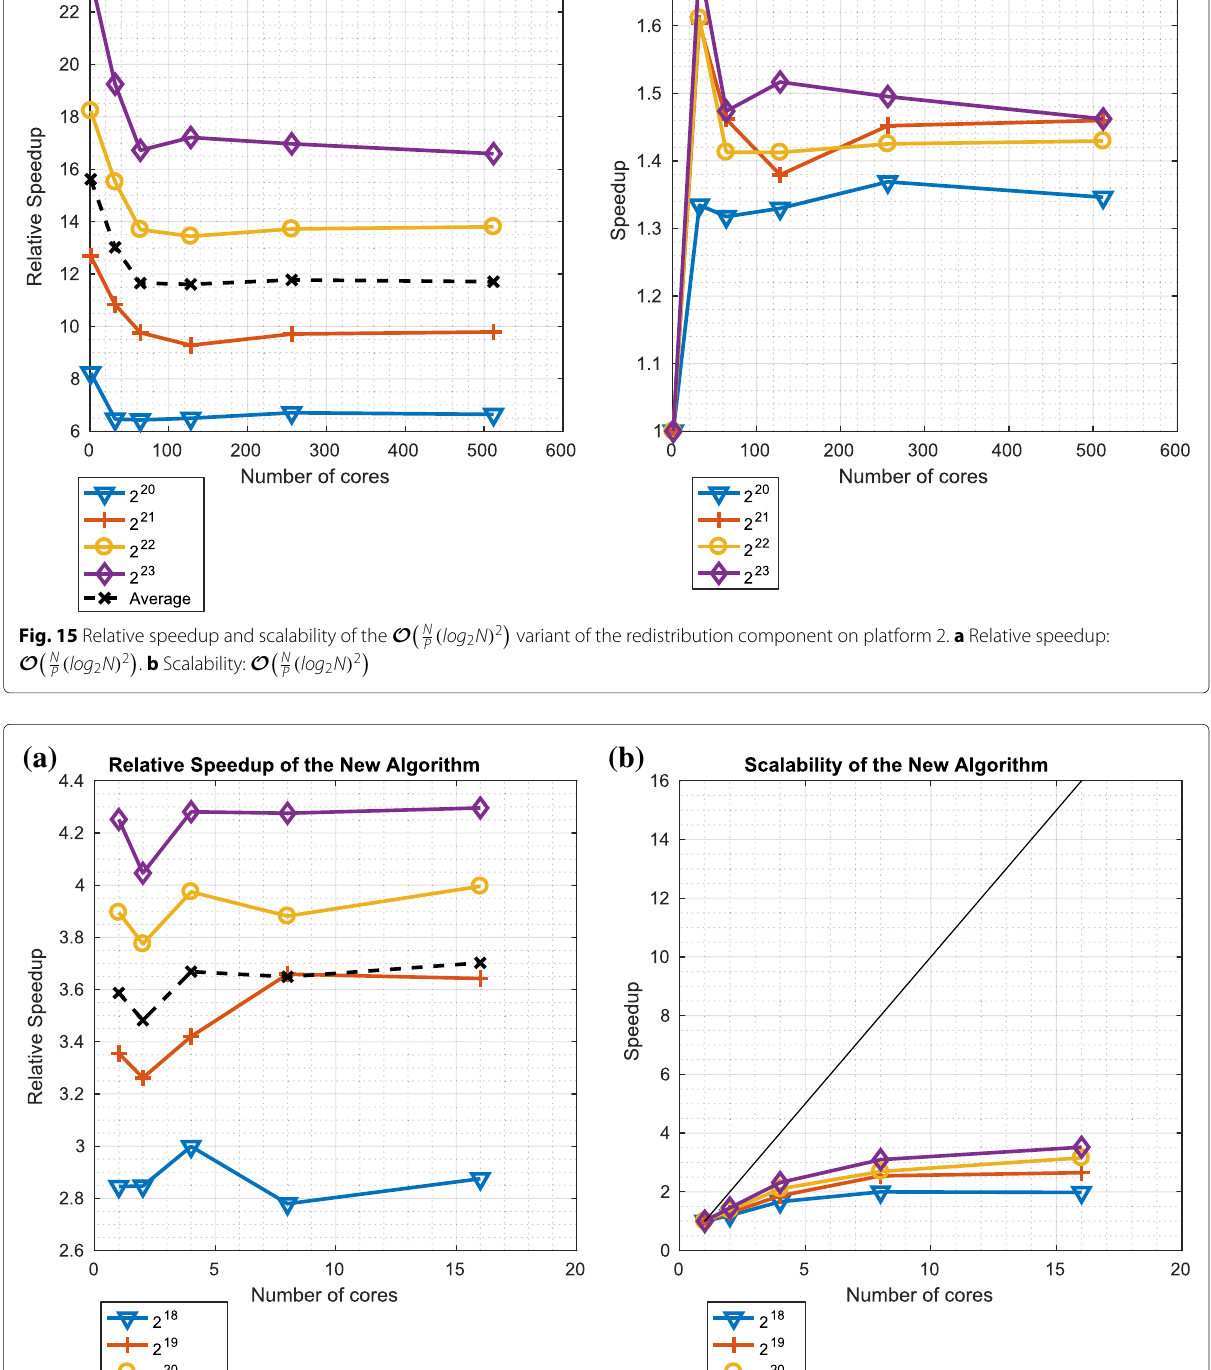
(cid:2) (cid:3) N ( log ) 2 variant of the redistribution component on 2 N P